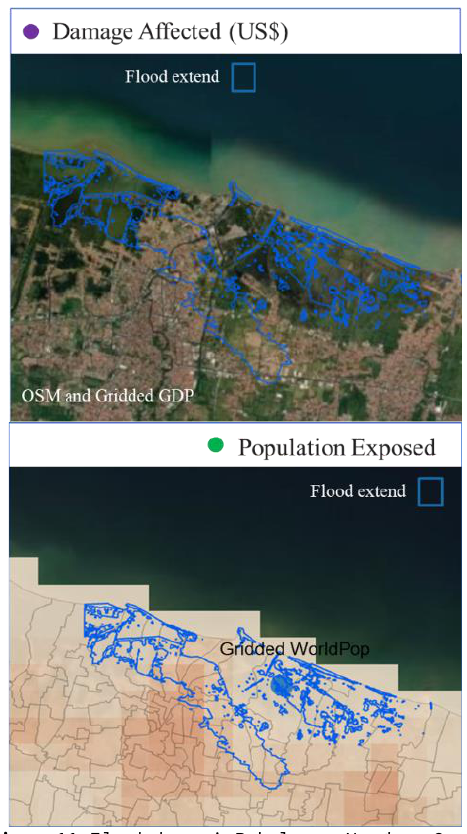
Figure 11. Flooded area in Pekalongan Northern